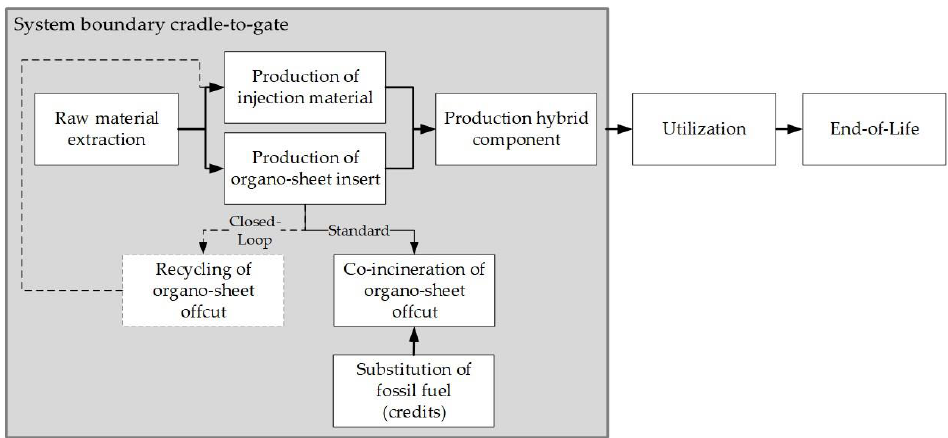
Figure 10. System boundary cradle-to-gate of the production of hybrid component for profitability and life cycle assessment of the considered strategies for organo sheet offcut.